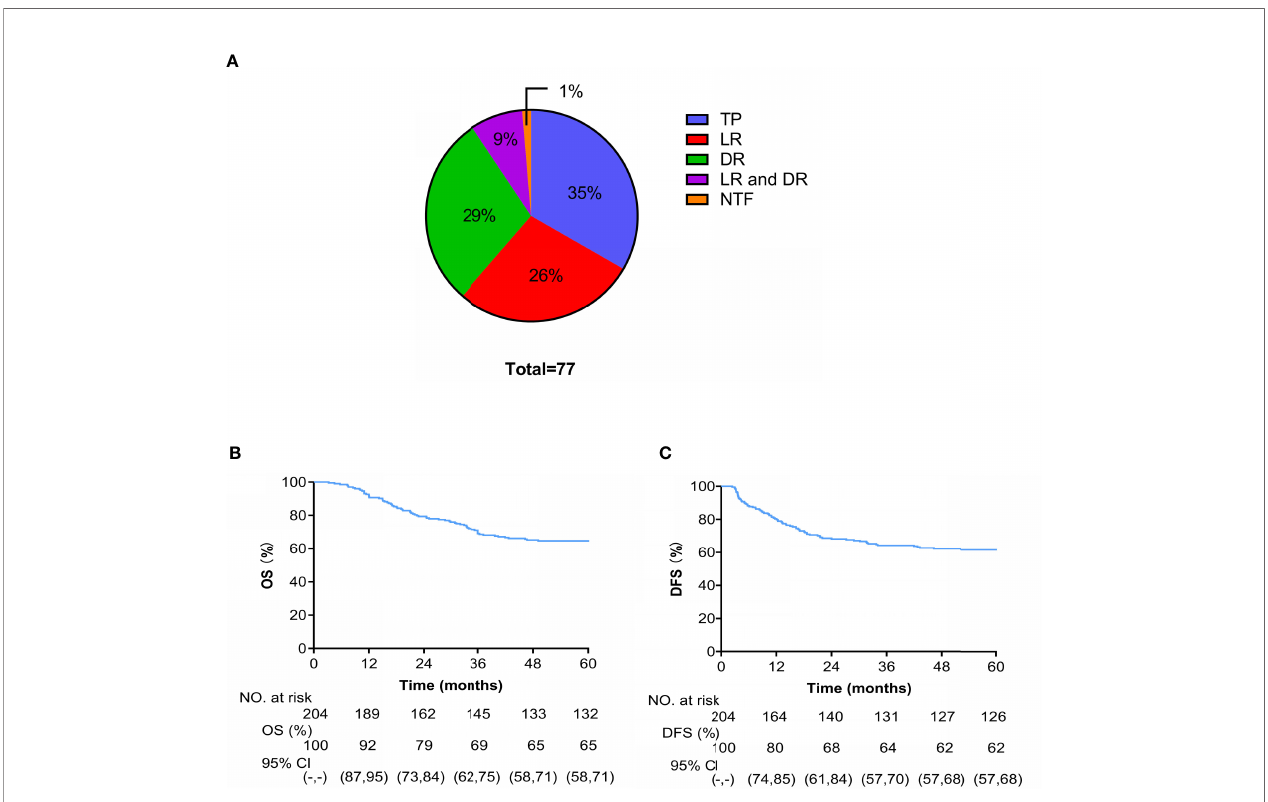
FIGURE 5 | (A) Cause-speci fi c of death (TP is tumor progression and NTF is non-tumor factors). Kaplan-Meier curves of OS (B) and (C) DFS.